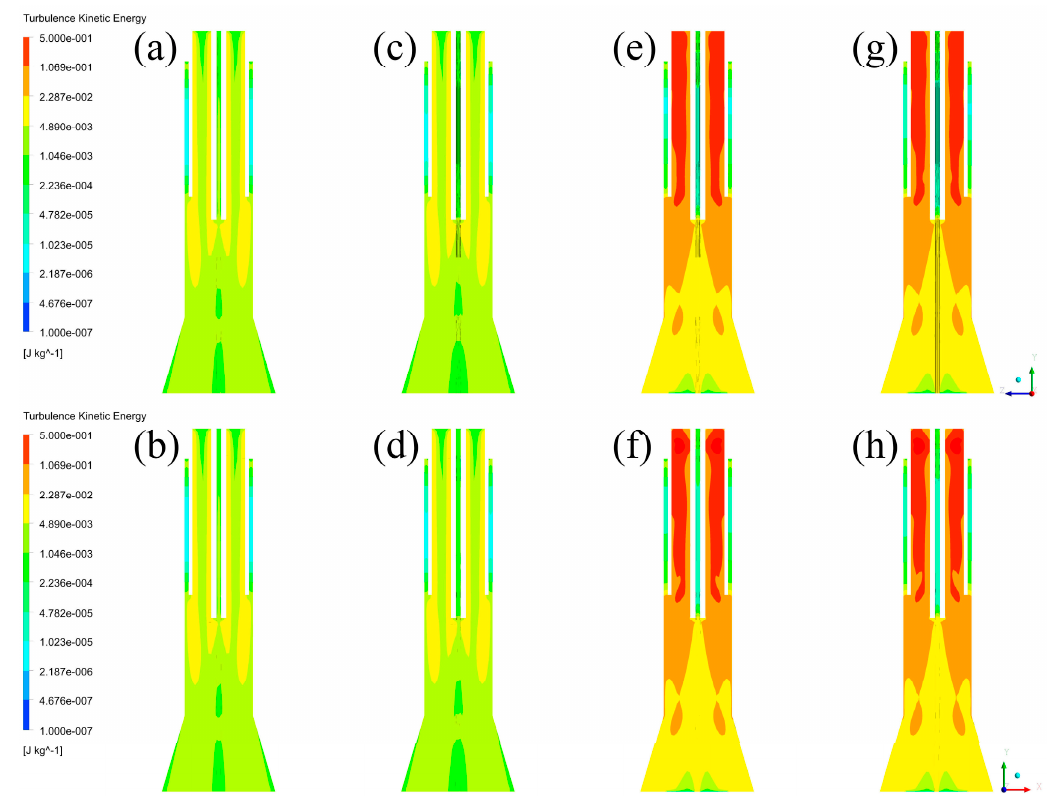
Figure 9. Turbulence kinetic energy distributions: ( a ) Case A in YZ plane, ( b ) Case A in XZ plane, ( c ) Case B in YZ plane, ( d ) Case B in XZ plane, ( e ) Case C in YZ plane, ( f ) Case C in XZ plane, ( g ) Case D in YZ plane, ( h ) Case D in XZ plane.